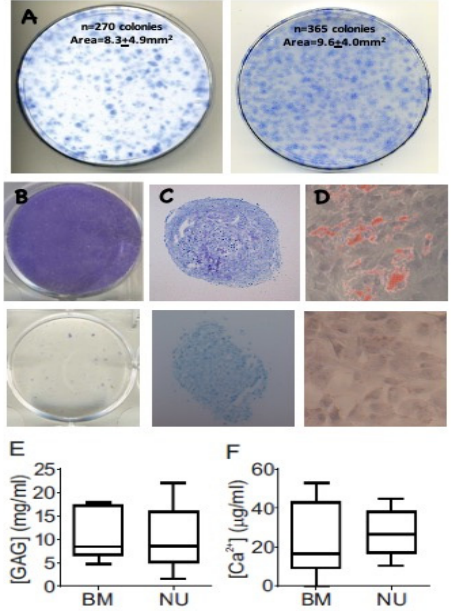
Figure 1. Colony formation ( A ) and multi-lineage di ff erentiation potential ( B – E ) of non-union (NU)-derived mesenchymal stromal cells (MSCs). Enzymatically digested non-union tissue readily forms similar-sized colonies in vitro ( A , left panel) compared with control MSCs derived from bone marrow (BM) aspirates ( A , right panel). Culture expanded adherent cells undergo osteogenic di ff erentiation, as shown by alkaline phosphatase staining ( B ); chondrogenic di ff erentiation, as shown by toluidine blue staining of chondrogenic pellets ( C ); and adipogenic di ff erentiation, as shown by oil red staining ( D ). The bottom panels on B – D show cells stained after culturing in normal growth media. Quantitative measurements of chondrogenesis, measured by glycosaminoglycan (GAG) accumulation ( E ), and osteogenesis, measured by accumulation of Ca 2 + ( F ), were comparable between BM MSCs (BM) ( n = 6) and non-union derived MSCs (NU) ( n =